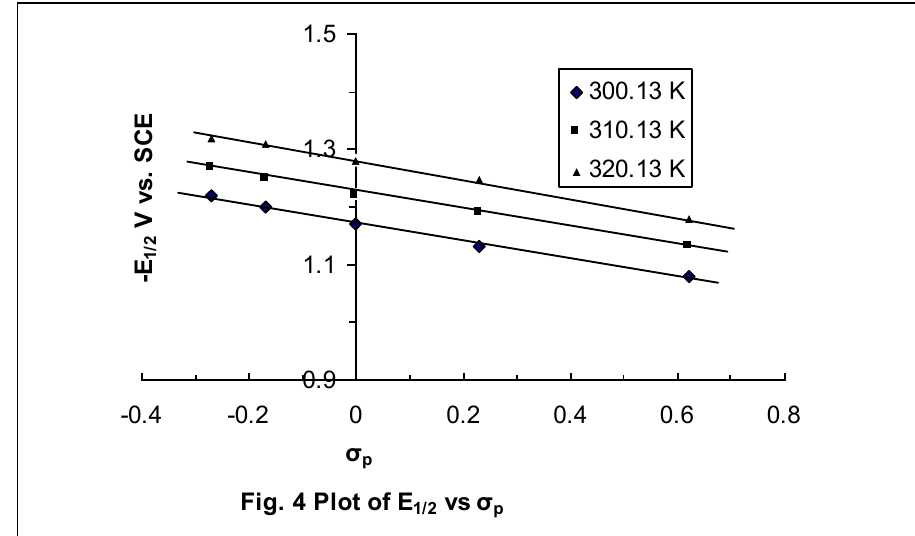
Fig. 4 Plot of E 1/2 vs σ